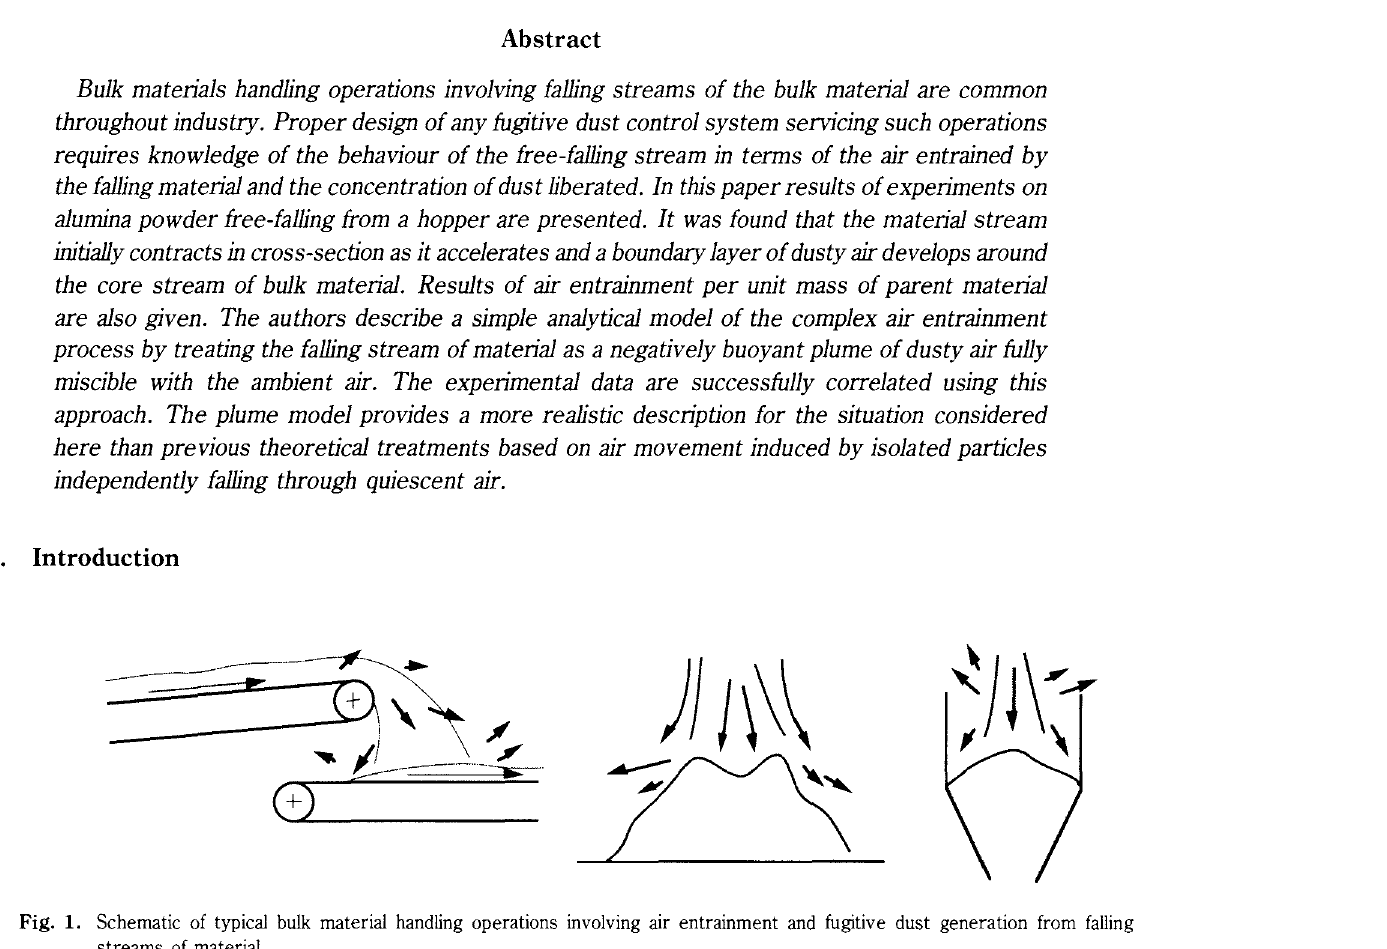
Fig. 1. Schematic of typical bulk material handling operations involving air entrainment and fugitive dust generation from falling streams of